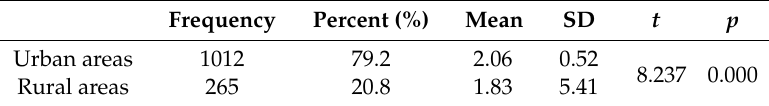
Table 3. Difference analysis of educational backgrounds when comparing parents from urban and rural areas in Beijing.